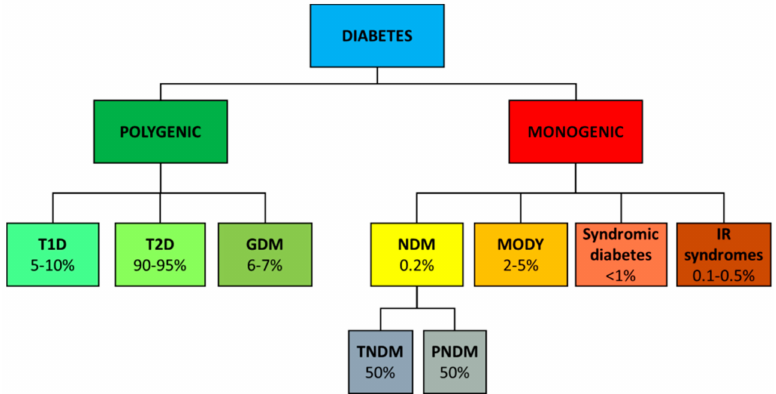
Figure 3. Classification of diabetes. Different diabetes and their rough